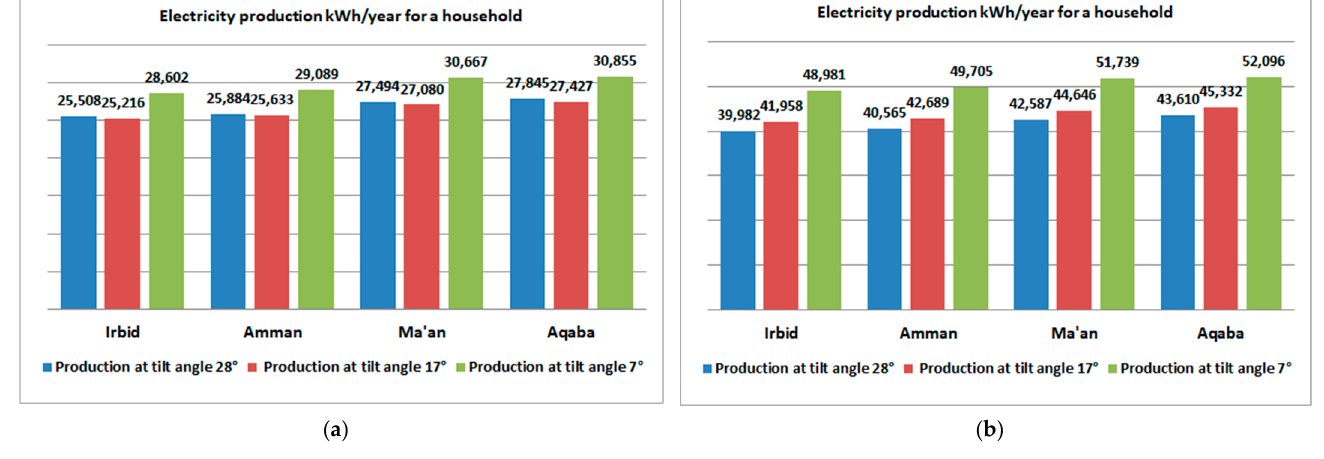
Figure 8. Electricity production for each household from the installation of PV systems on the rooftops of ( a ) single houses and ( b ) villas.